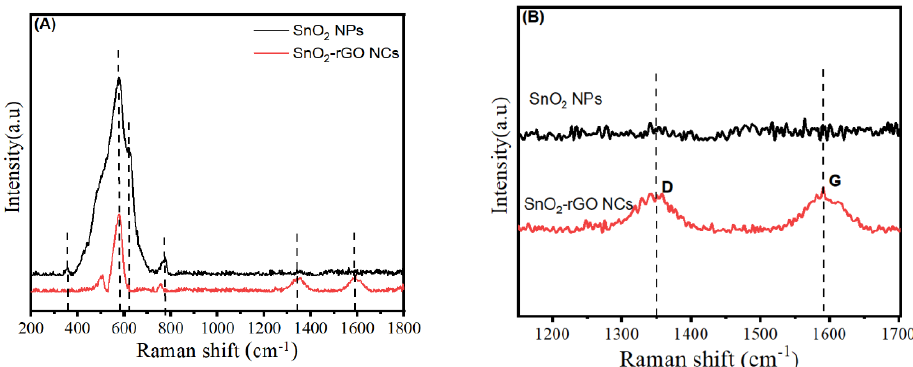
Figure 6. Raman spectra of the SnO 2 NPs and SnO 2 -rGO NCs ( A ); magnified Raman spectra of the SnO 2 NPs and SnO 2 -rGO NCs ( B ).